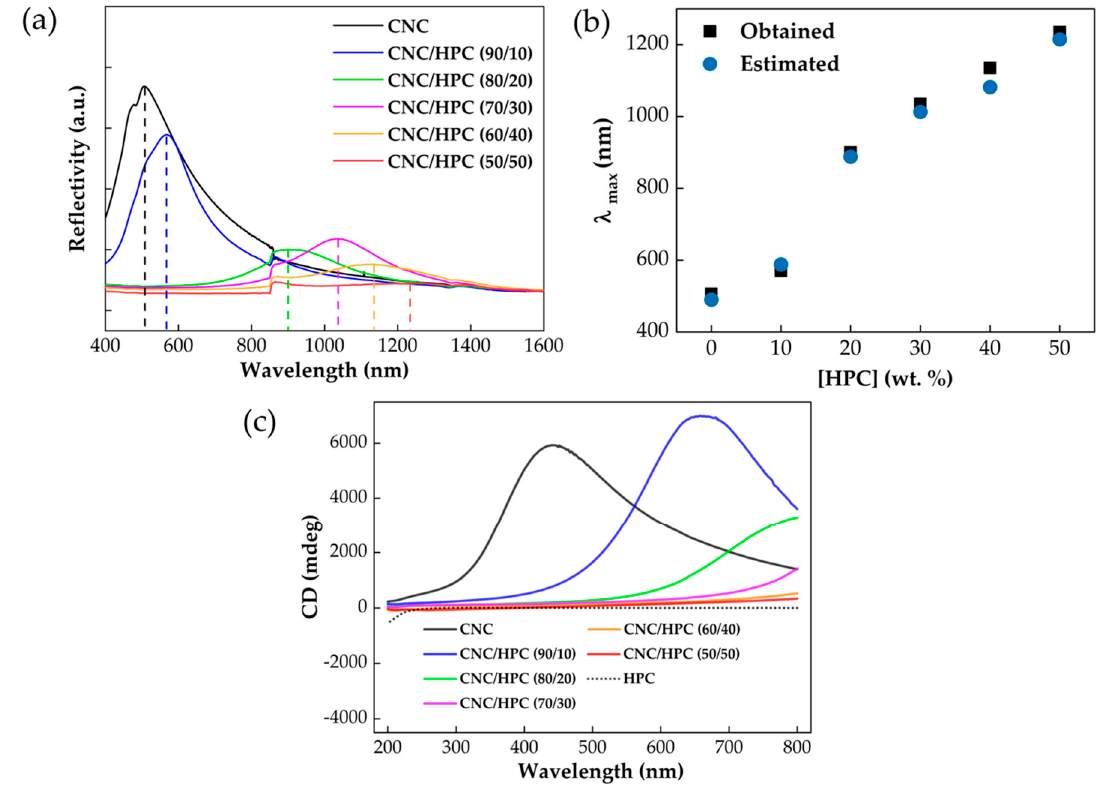
Figure 4. ( a ) Reflectance spectra captured from the marked region of CNCs and CNC/HPC composite films across the visible and near-infrared regions of the electromagnetic spectrum of light, where it can be seen that the increase in HPC content leads to an increase of the maximum wavelength reflected to the near-infrared region; ( b ) maximum reflected wavelength plotted as a function of HPC concentration in the composite system, black squares represent the obtained values from reflectance spectra, whilst blue dots represent the estimated values using Equation (1), where the average pitch value was measured from SEM images, like the ones presented in Figure 3; ( c ) corresponding circular dichroism spectra of CNCs, CNC/HPC, and of a neat HPC film.